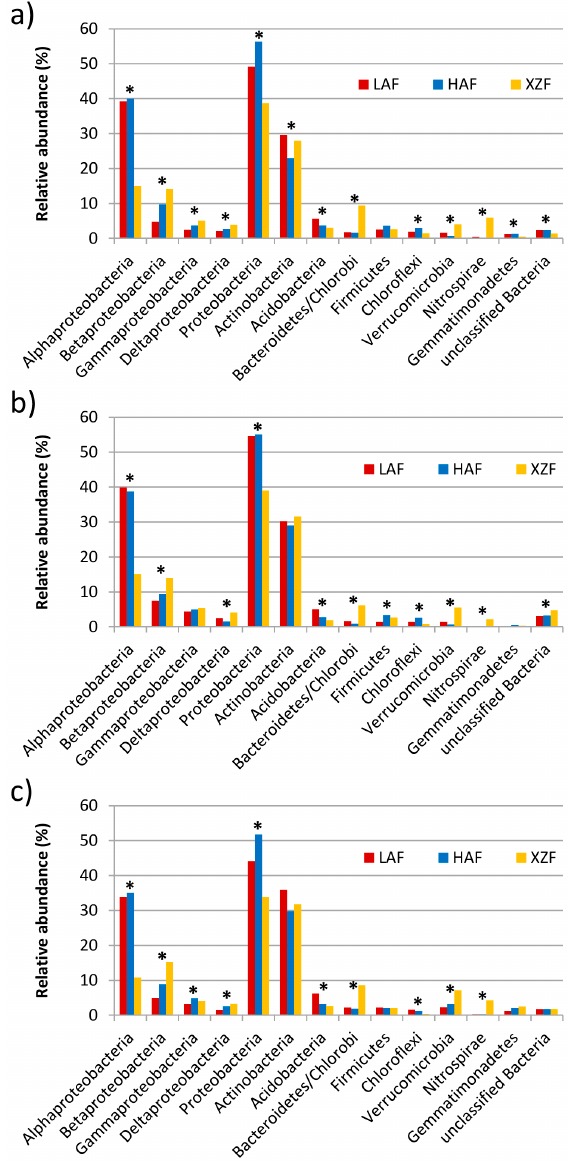
Figure 5. Phylogenetic classification and relative abundance at the phyla level for methane metabolism ( a ), sulfur metabolism ( b ) and nitrogen metabolism ( c ) sequences, performed by BLASTX analysis against the Greengenes genome database using the IMG/JGI web server. The Y axis represents the relative abundance of each taxon expressed as a percentage. Phylogenetic classification of the Proteobacteria is also shown at the class level. Functional groups with statistically significant differences between samples are marked with asterisks.